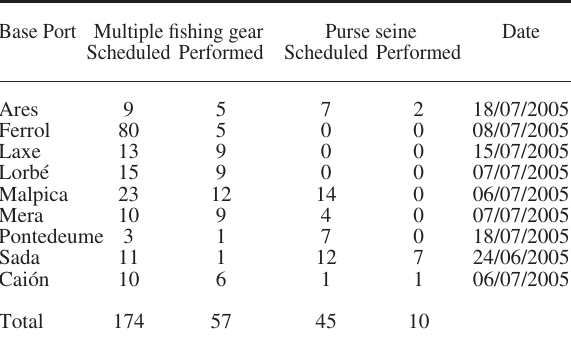
Table 2. – number of interviews with ship-owners and skippers for each fishing gear used. interview dates are